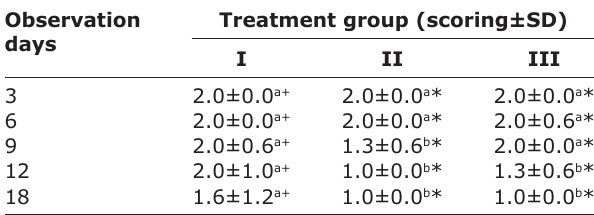
Table-2: Observation of subjective pain response test.